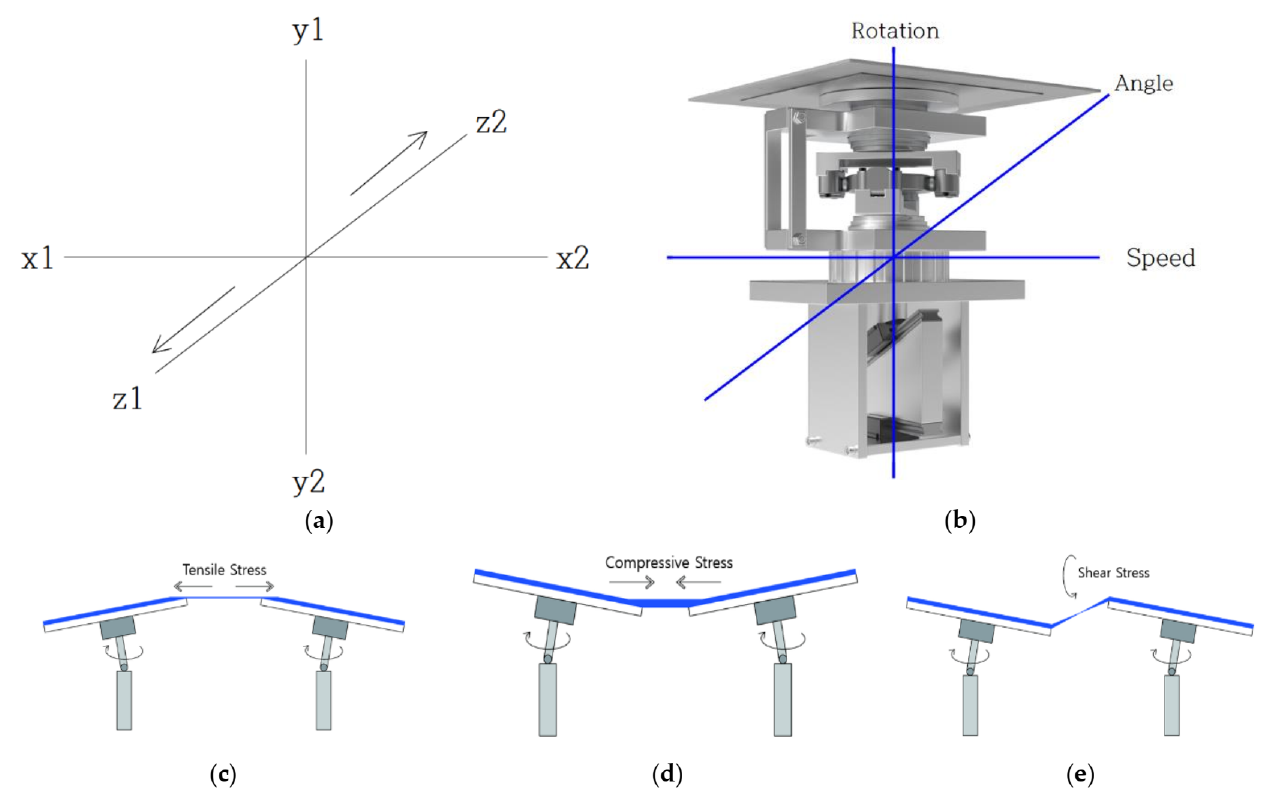
Figure 9. Concept of three-axis operation for stress generation based on rotation, speed, and angle using the motor device: ( a ) schematic diagram of triaxial stress generation, ( b ) schematic diagram of 3-axis drive of rotation, speed, and angle, ( c ) tensile stress simulation, ( d ) compressive stress simulation, ( e ) shear stress